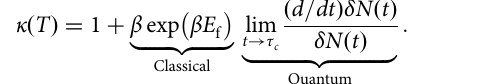
Fig. 5 Thermal properties of the double-well potential. Comparing the thermal properties of the double-well potential as a function of the temperature to verify the validity of the low-temperature correction. a Showing the position-momentum uncertainty, in this system, 0.5 denotes the minimum uncertainty asserted by Heisenberg's uncertainty principle. b The S 2 linear entropy. The low-temperature correction, E ω , is shown as the solid line in blue, whereas the high-temperature approximation, k B T , is shown in a dashed red